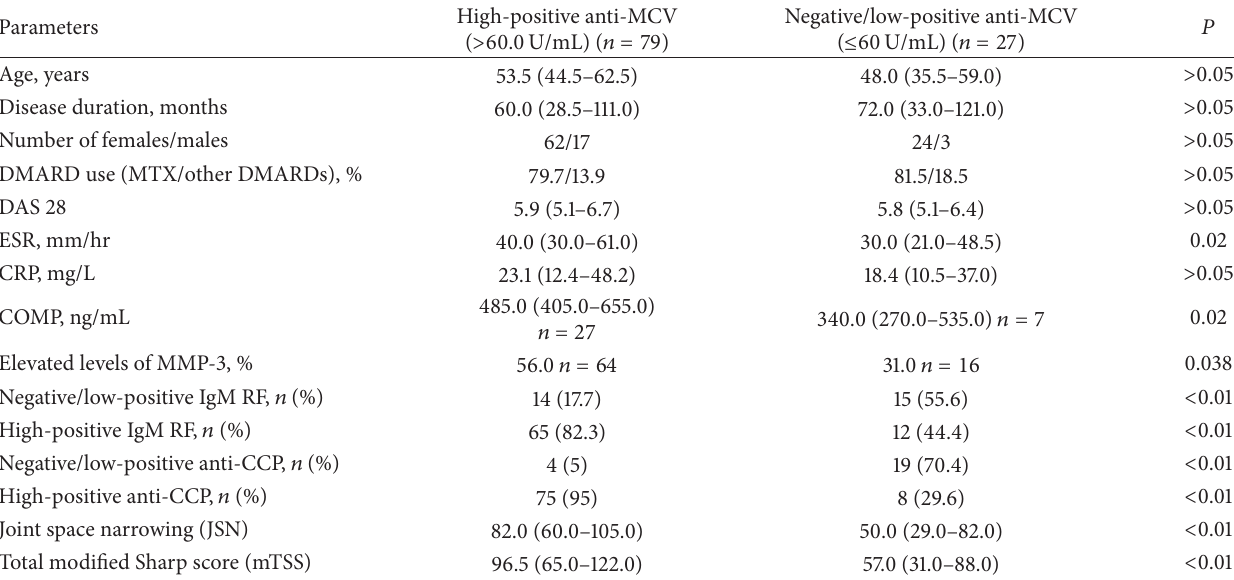
Table 2: Characteristics of RA patients depending on the level of positivity for anti-MCV, Me